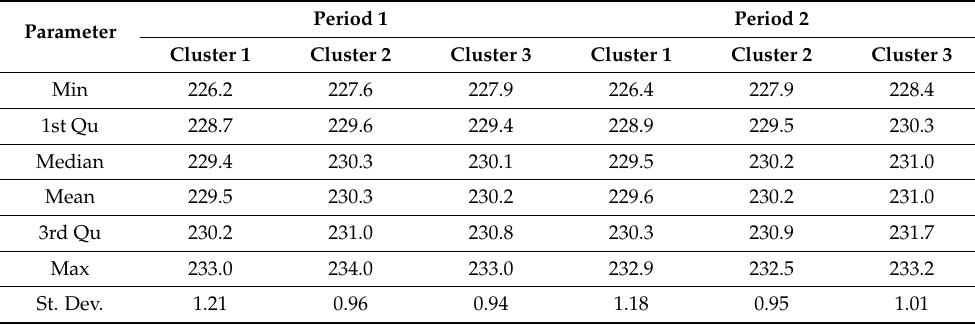
Table 6. Descriptive statistics of the voltage in phase L2 at the tested measuring point.